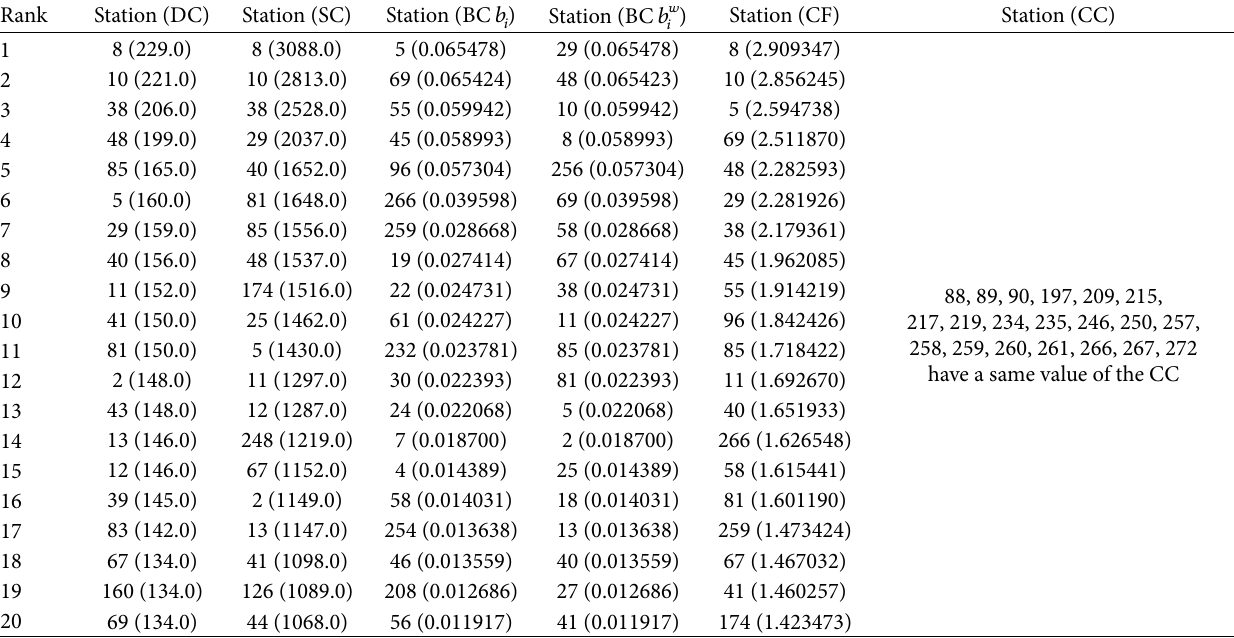
Figure 9: (a) Distributions of CC and (b) CC versus DC. Table 2: Ranking of top 20